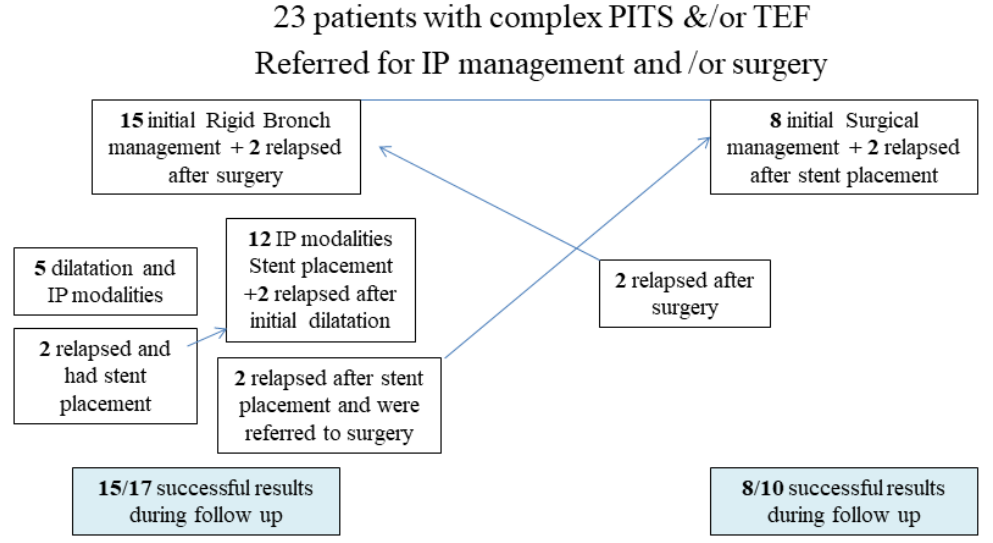
Figure 4. Histogram depicting the multi-disciplinary management of our patients and their long-term outcome.